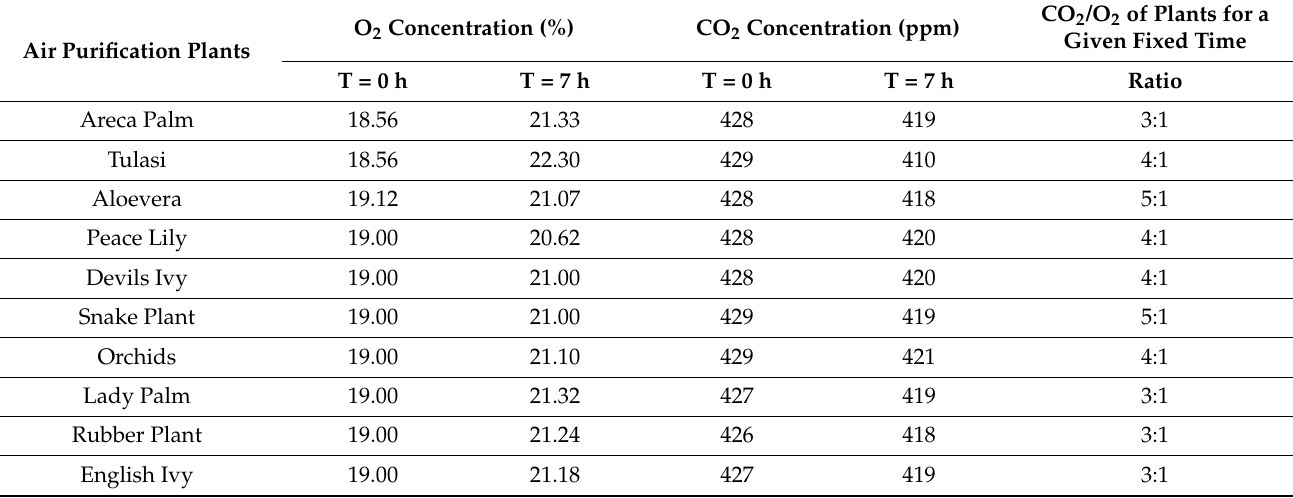
Table 2. Measurement equipment.